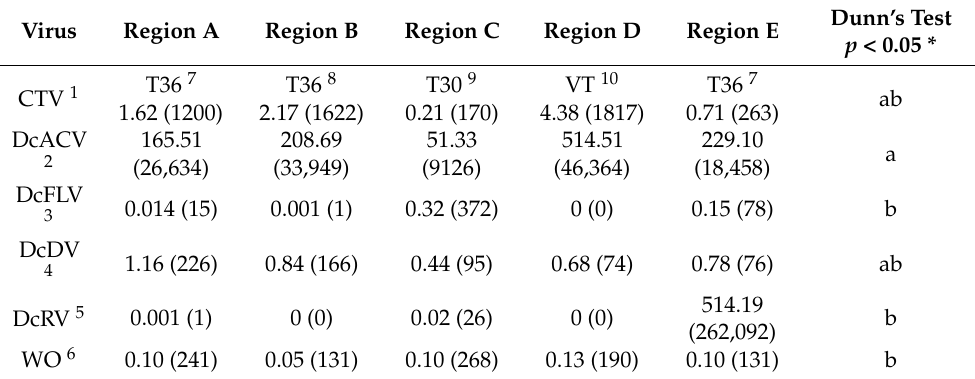
Table 6. Abundance of viruses (with detected contigs of interest) in Group 2020 Florida Regions A–E. Virus Region A Region